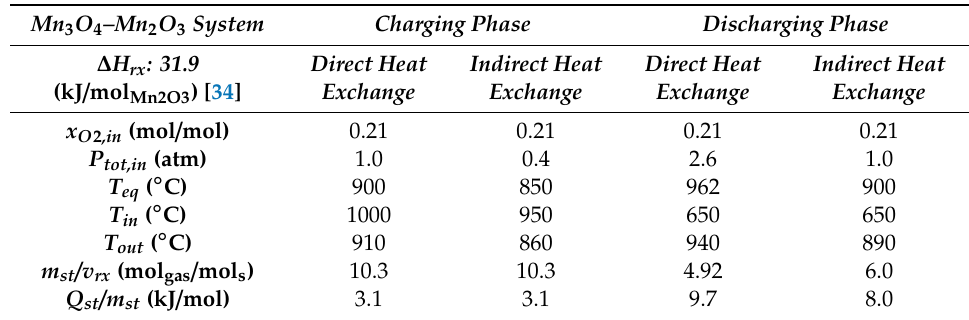
Table 4. TCS operating conditions for the manganese oxide system (open cycle and adiabatic reactor).